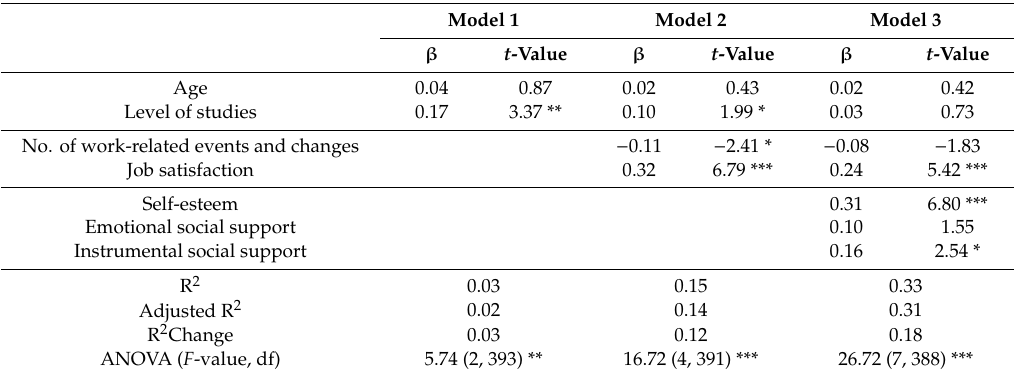
Table 5. Summary of the hierarchical multiple regression analysis with life satisfaction as a dependent variable for the female